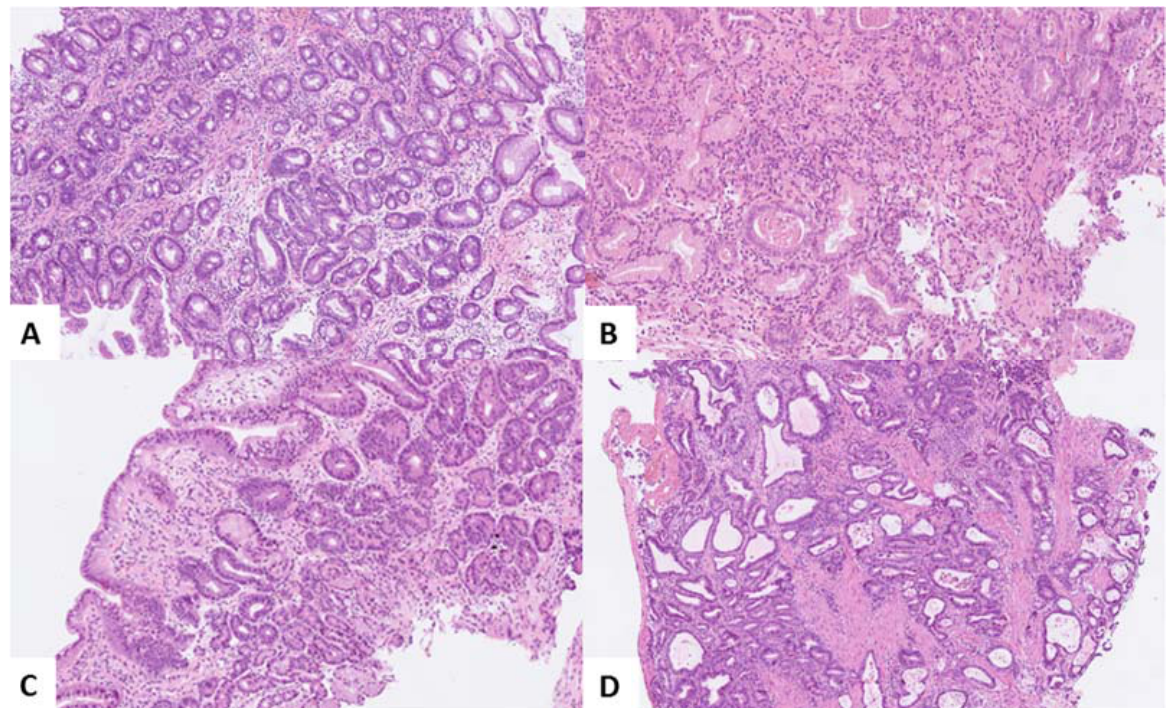
Figure 1. Hematoxylin–eosin staining of ( A ) Barrett’s esophagus (BE) without dysplasia (NDBE); ( B ) BE with low-grade dysplasia (LGD); ( C ) BE with high-grade dysplasia (HGD); and ( D ) esophageal adenocarcinoma (EAC). Original magnifications ×50 [A and D], ×80 [C] and ×100 [B]).